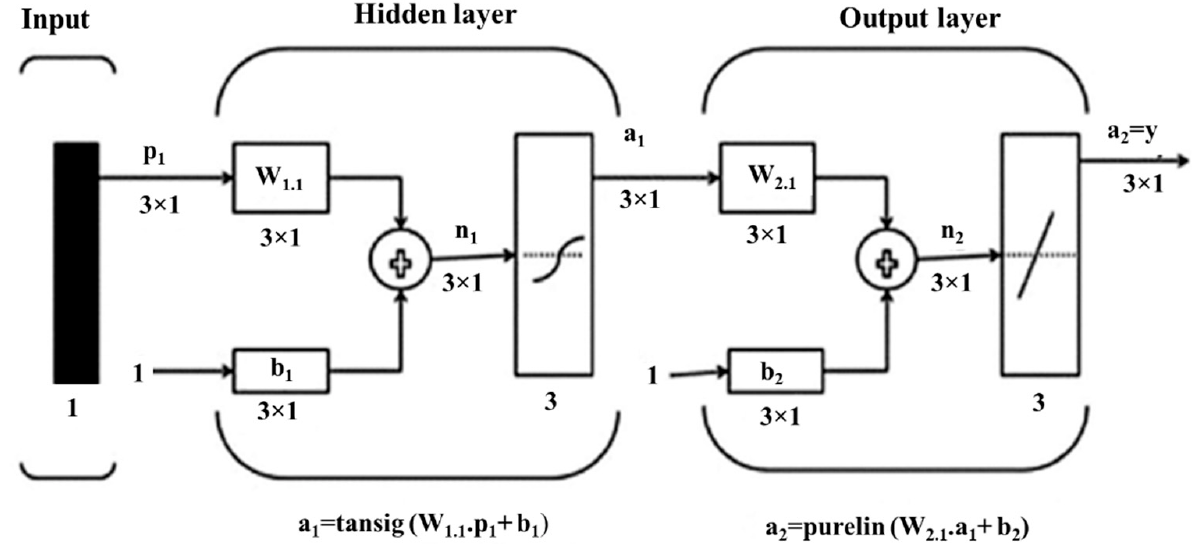
Figure 10. The proposed two-layer feedforward network to calibrate the soft sensor.